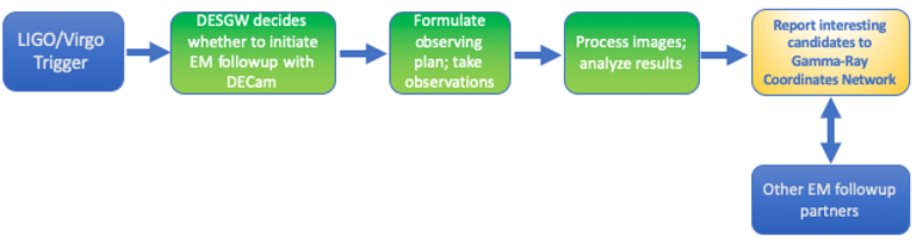
Figure 1. Overview of the DESGW gravitational wave follow-up program